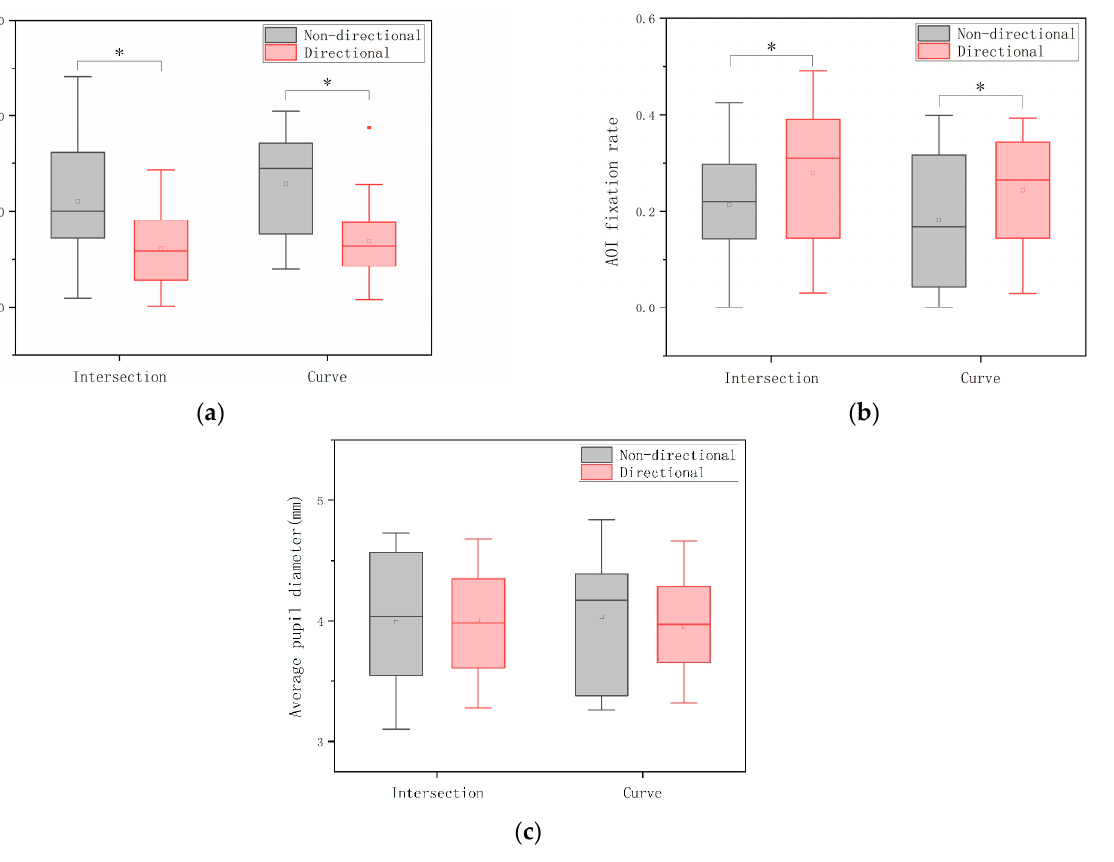
Figure 5. ( a ) The time to the first fixation on AOI for different auditory TORs; ( b ) AOI fixation rate for different auditory TORs; and ( c ) average pupil diameter for different auditory TORs. (* p < 0.05 ; ▪ : outlier).